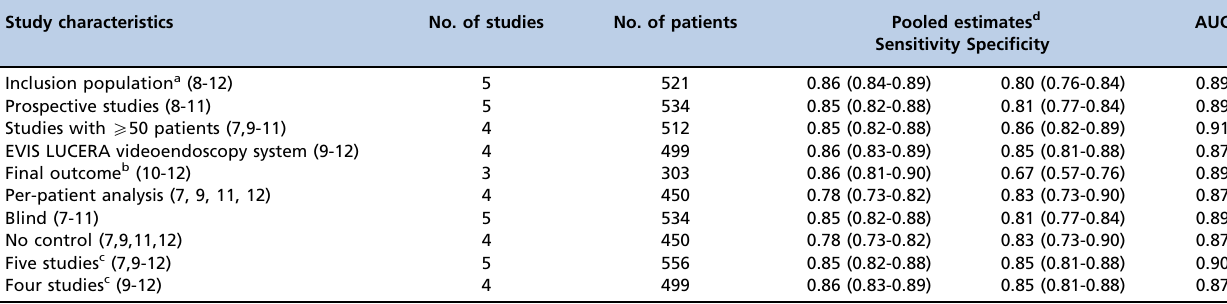
Table 2 - Outcomes of the sensitivity analysis of selected studies assessing the stability of the accuracy of NBI for diagnosing early and invasive lung cancer Study